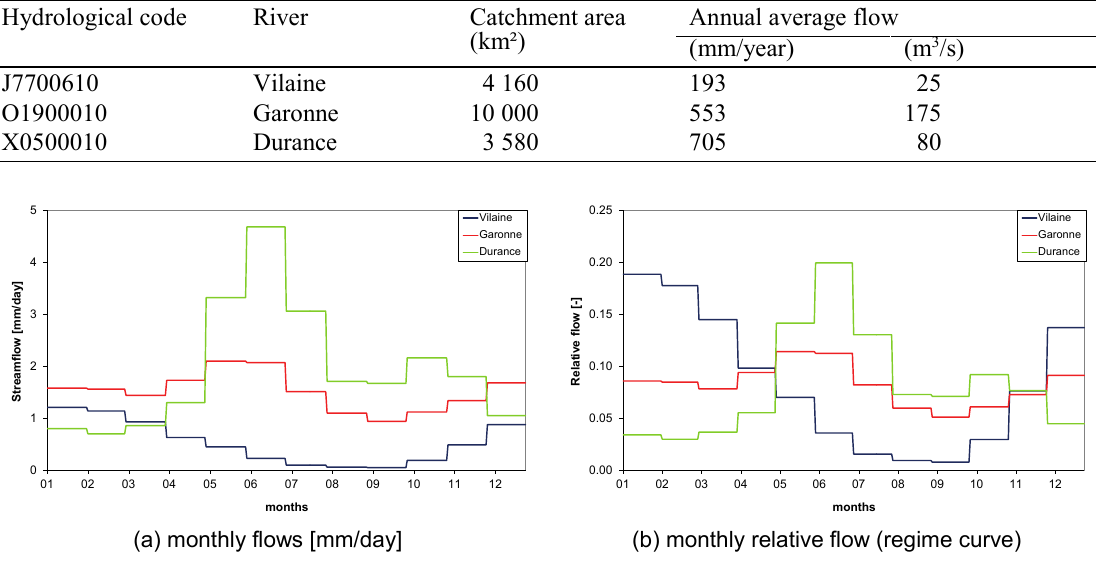
Fig. 1 Seasonal flow characteristics of the three French rivers examined in this paper.